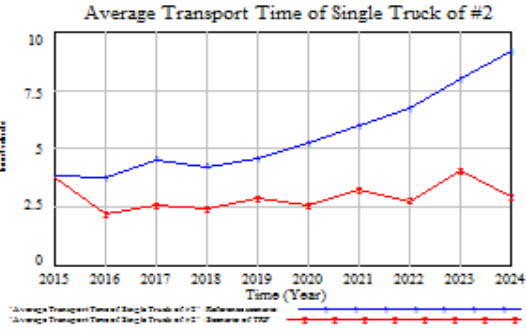
Figure 7. TRP effects on the average transport time of a single truck using the regular highway